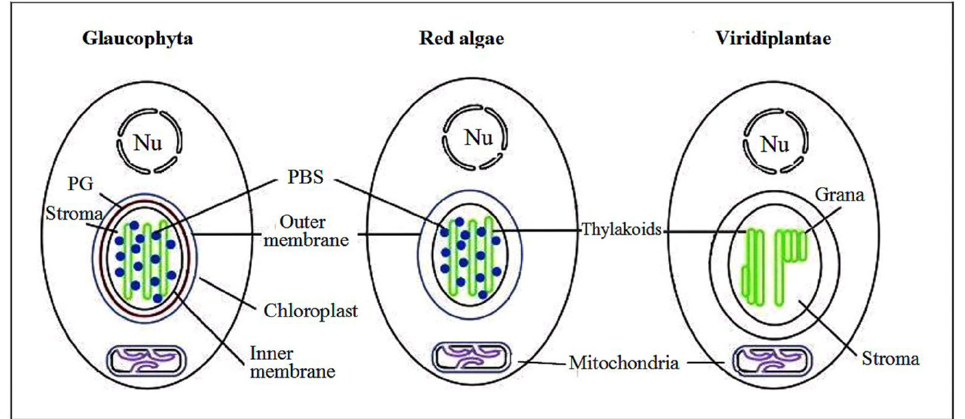
Figure 3. Three types of Archaeplastida double membrane chloroplasts. In glaucophytic algae (as well as in photosynthetic amaoebae), the chloroplast retains PBSs and the peptidoglycan layer (PG). Red algae retain PBSs, but the peptidoglycan layer is eliminated. In plastids of Viridiplantae, PBSs and peptidoglycan layers are lost while thylakoids form grana regions (similarly to Prochlorophyta). In the genome of the high-light-adapted strains, only a single and free-standing cpeB gene occurs. This gene encodes a derived form of β -PE, the function of which has remained enigmatic thus far [45]. Interestingly, degenerated forms of the α and β subunits of other